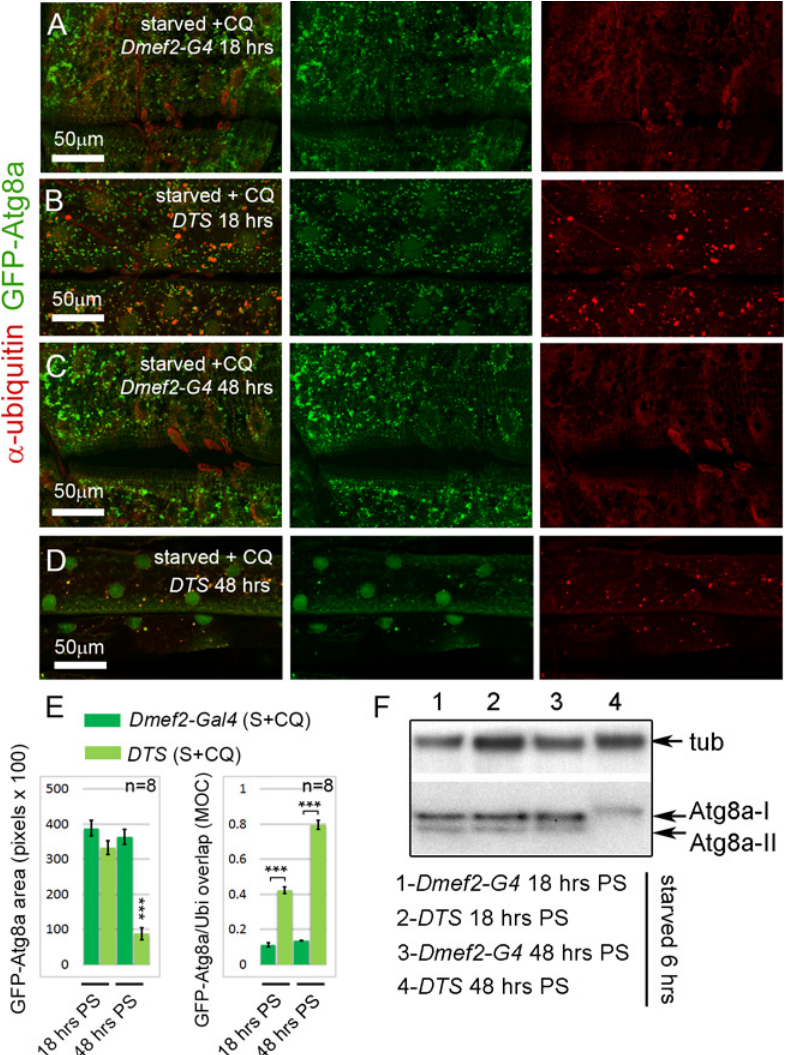
Fig 4. Short-term, but not long-term, proteasome disruption triggers autophagic clearance of aggregates (A-D) Inhibition of the proteasome by overexpression of a temperature sensitive proteasome mutant (DTS). Dmef2-Gal4 , UAS-GFP-Atg8a control and UAS-DTS; Dmef2-Gal4 , UAS-GFP-Atg8a and animals were shifted to the restrictive temperature then starved and CQ treated 6 hrs prior to dissection. 18 hrs post-shift (PS), both control (A) and DTS muscles (B) accumulate GFP-Atg8a punctae, but the latter also accumulate ubiquitin (Ubi) aggregates. 48 hrs PS, control muscles (C) maintain strong autophagy induction, but DTS mutant muscles (D) have reduced GFP-Atg8a punctae accumulation, similar to the Rpn1 knockdown phenotype. (E) Quantification of the mean GFP-Atg8a punctae and Mander ’ s overlap coefficient for GFP-Atg8a and Ubi for genotypes shown in A-D (SEM is indicated for n = 8 ventral longitudinal muscles from individual animals with p-values of DTS relative to control). Dark green = Dmef2-Gal4 , UAS-GFP-Atg8a ; Light green = UAS-DTS; Dmef2-Gal4 , UAS-GFP-Atg8a . (F) Western blot analysis of endogenous Atg8a from third instar muscle lysate. 6 hrs starvation induces lipidated Atg8a-II in Dmef2-Gal4 control at both 18 hrs and 48 hrs PS, but not in DTS at 48 hrs